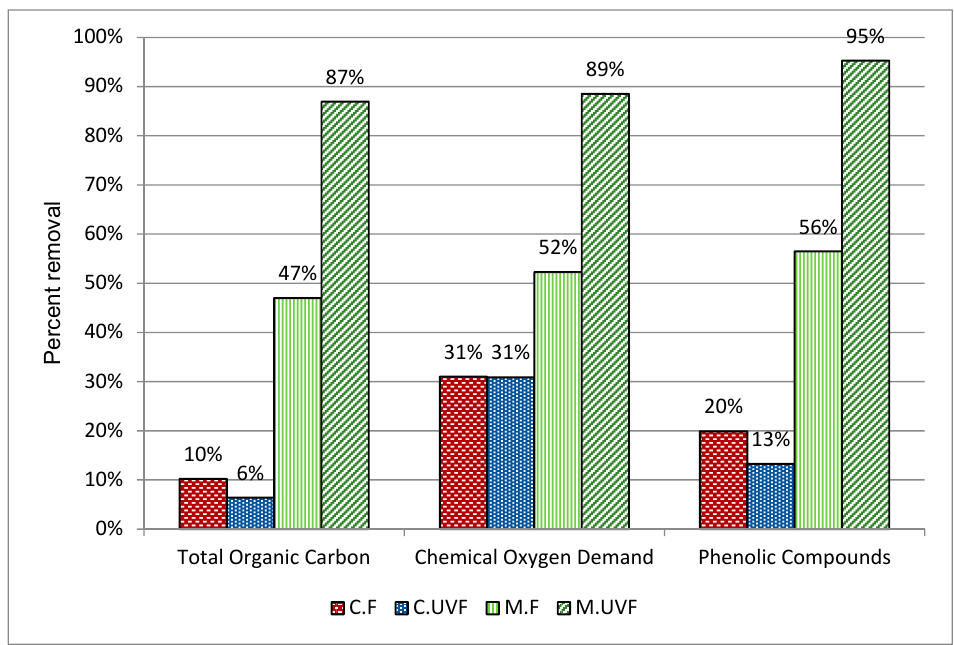
Figure 5. Percent removals of the analyzed compounds after 20 min of experiment.